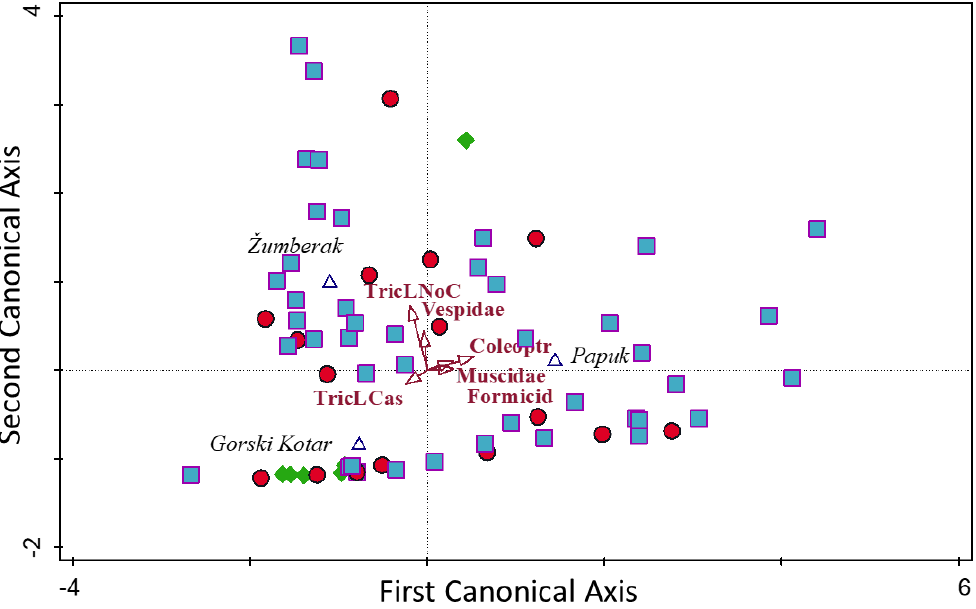
Figure 2. Canonical variate analysis plot of consumed prey items ( → ) within regions Δ (Gorski Kotar, Žumberak and Papuk) and between Danube (DA = ), Atlantic (AT = ) and hybrid